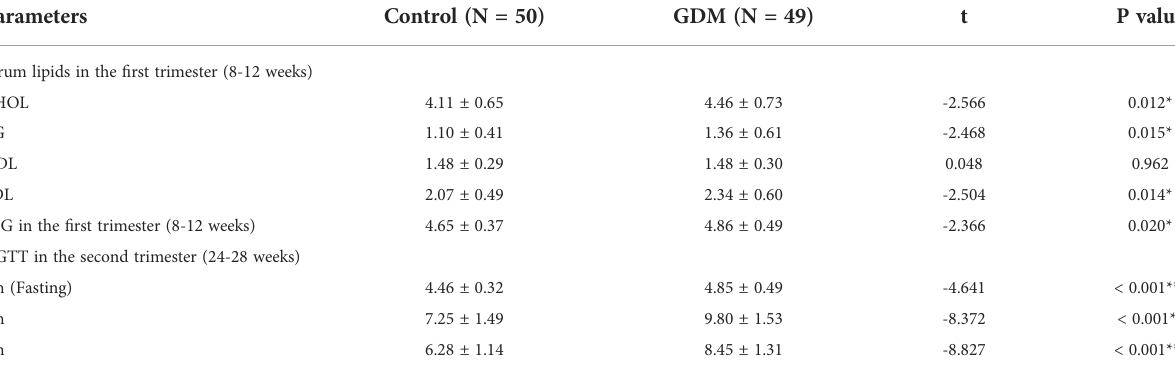
TABLE 2 The serum lipids, fasting plasma glucose (FPG), and oral glucose tolerance test (OGTT) in patients with gestational diabetes mellitus (GDM) and controls. Parameters